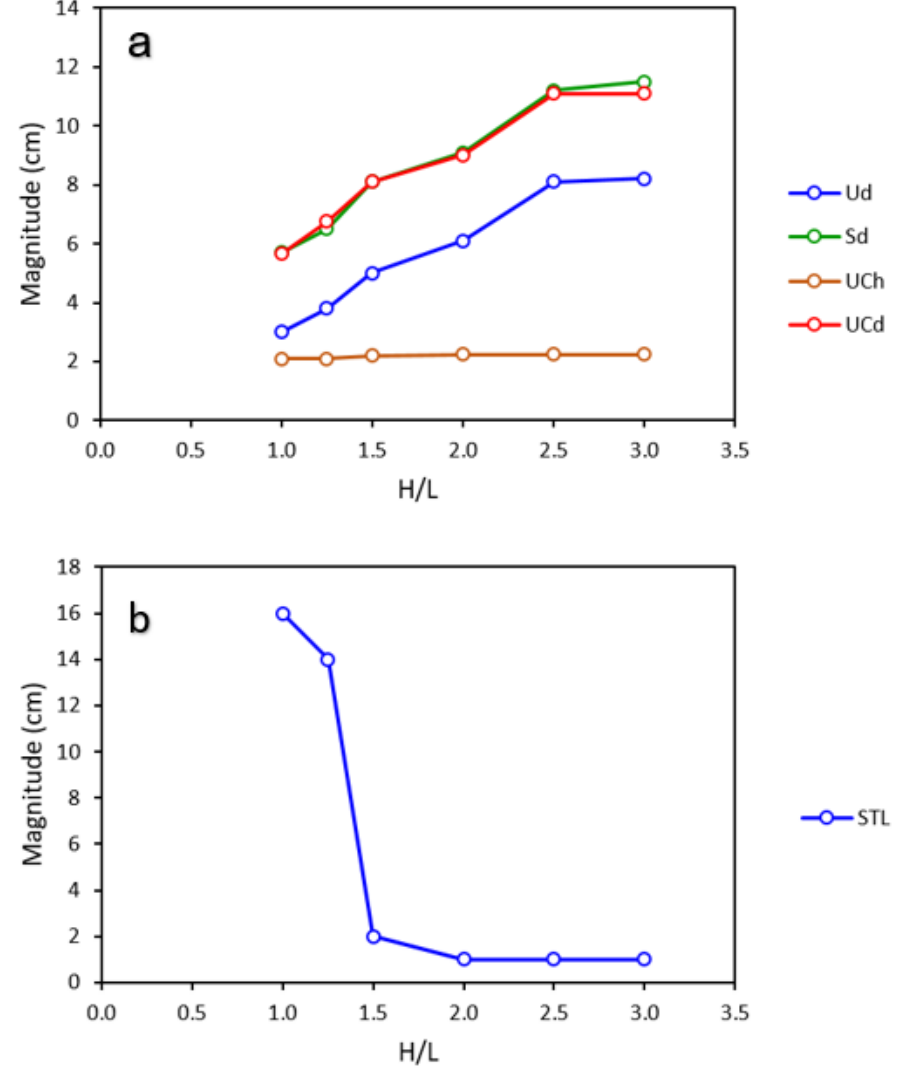
Figure 17. Effect of building height on sand accumulation around single-standing buildings. ( a ) Effect on Ud, Sd, Uch, and Ucd; ( b ) Effect on STL. (See Figure 16 for explanation of symbols).